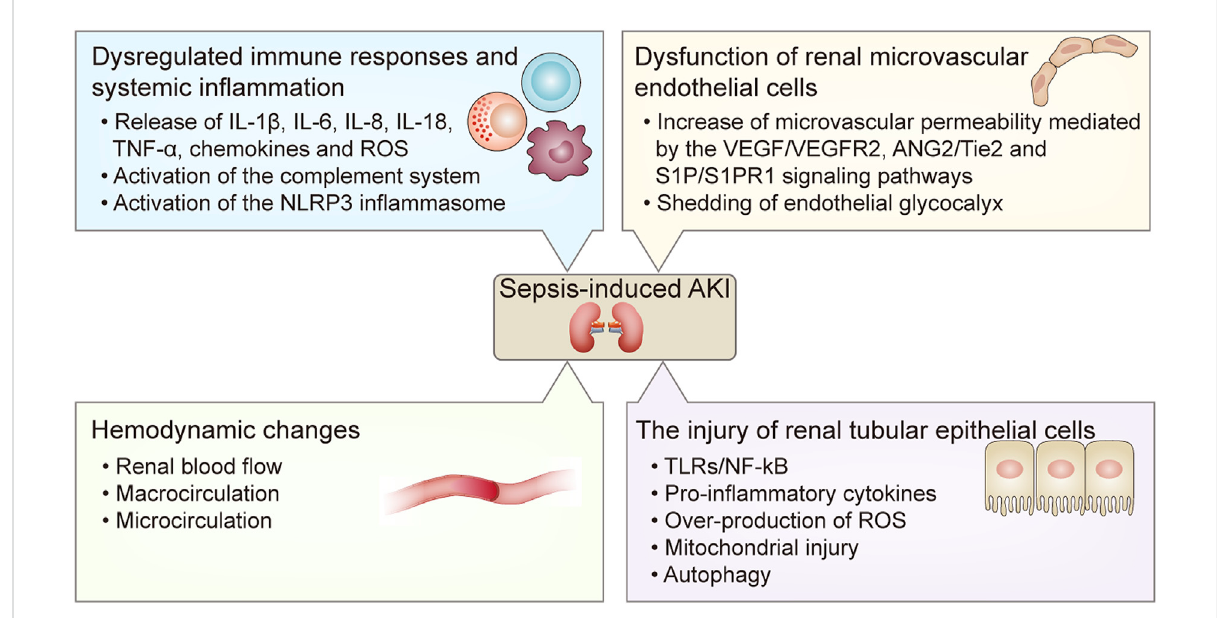
FIGURE 1 The pathogenesis of sepsis-induced AKI. The pathogenesis of sepsis-induced AKI includes 1) dysregulated immune responses and systemic in fl ammation including therelease of pro-in fl ammatory cytokinessuch as IL-1 β , IL-6, IL-8, IL-18, TNF- α , chemokinesand ROS, and theactivation of the complement system and the NLRP3 in fl ammasome; 2) hemodynamic changes including alterations of renal blood fl ow, macrocirculation and microcirculation;3)dysfunctionofrenalmicrovascularendothelialcellsincludingincreasedmicrovascularpermeabilitymediatedbytheVEGF/ VEGFR2,ANG2/Tie2,andS1P/S1PR1signalingpathways,andsheddingofendothelialglycocalyx;4)theinjuryofrenaltubularepithelialcellsmediated by the TLRs/NF- κ B signaling pathway and reduced autophagy at the late stage of sepsis, which result in the release of pro-in fl ammatory cytokines and over-production of ROS and mitochondrial injury. AKI, acute kidney injury; IL, interleukin; TNF- α , tumor necrosis factor- α ;ROS, reactive oxygen species; NLRP3, nucleotide-binding oligomerization domain-like receptor protein 3; VEGF, vascular endothelial growth factor; VEGFR2, VEGF receptor 2; ANG2, Angiopoietin 2; TLRs, Toll-like receptors; NF- κ B, nuclear factor kappa B.